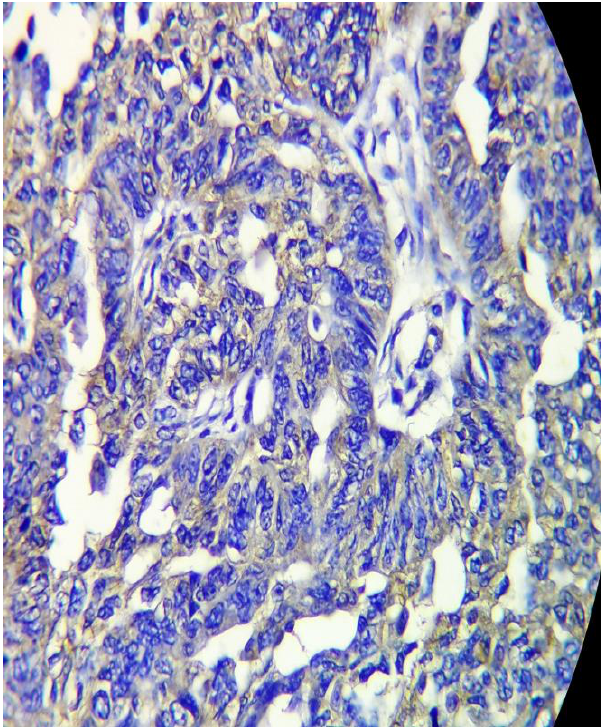
Figure 2 Moderately differentiated serous carcinoma stained with anti CD44v6 showing positive brown cell membrane&/or cytoplasmic immunostaining with scoring index 4, (40x).